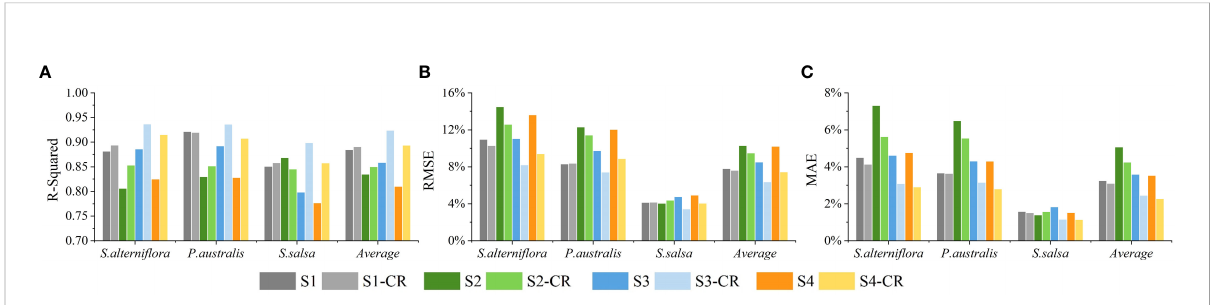
FIGURE 4 (A) R-square, (B) RMSE and (C) MAE of the fractional cover estimation of different salt marsh vegetation species from four scenarios using Random Forest Regression model. S1~S4: Scenario 1 ~ Scenario 4 based on the original Landsat imagery; S1-CR ~ S4-CR: Scenario 1 ~ Scenario 4 based on the cloud-removed Landsat imagery.